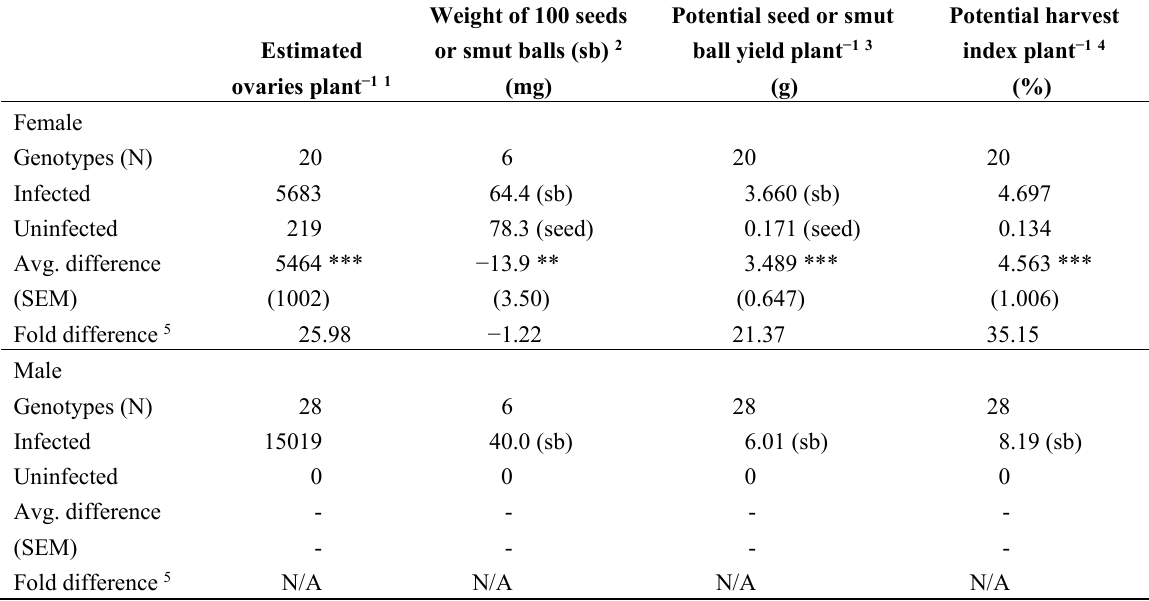
Table 3. Potential seed yield and potential harvest index for female and male genotypes of buffalograss that were either infected or uninfected with the pistil smut fungus. For each genotype, two replicate clonal plants were infected with pistil smut and two remained uninfected. Means are the clonal averages across genotypes from greenhouse grown